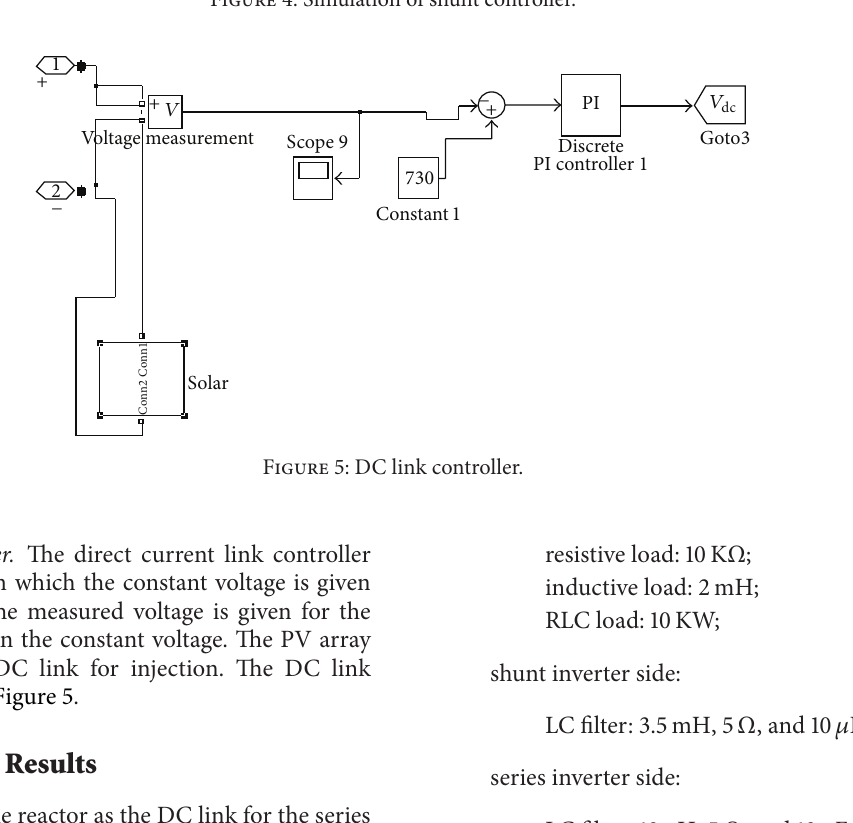
Figure 4: Simulation of shunt controller.